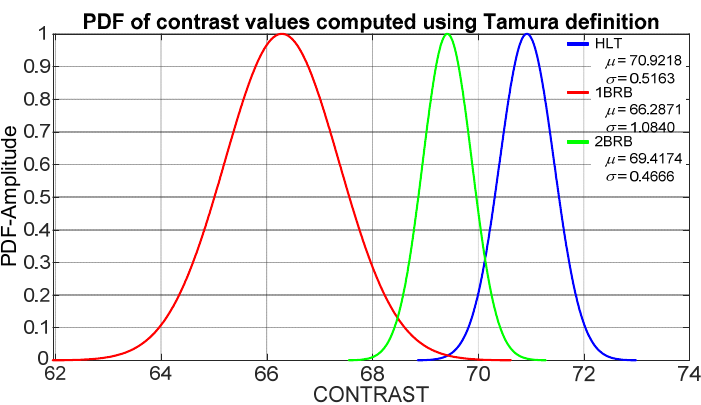
Figure 7. Fuzzy set entries based on Unser definition of contrast.